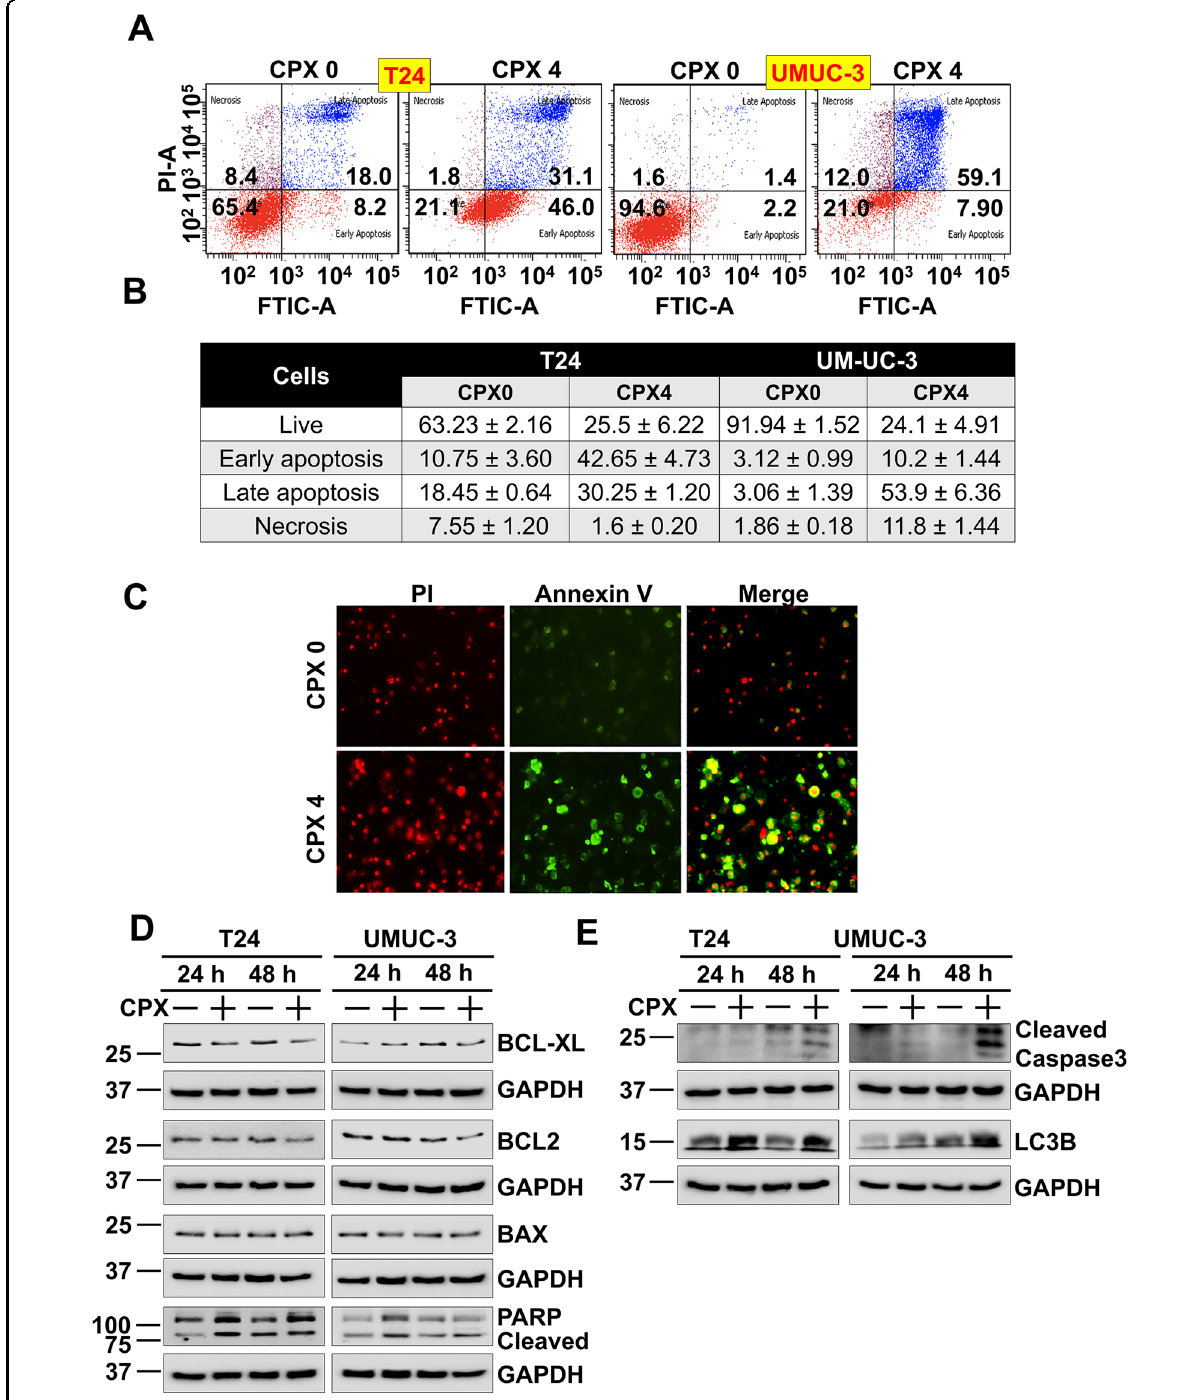
Fig. 3 CPX induces apoptosis in bladder cancer cell lines. A T24 and UM-UC-3 cells were treated with CPX stained with Annexin V (FITC) and PI, and analyzed by fl ow cytometry. CPX treatment induced signi fi cant early and late apoptosis in T24 and UM-UC-3 cells. B The fl ow cytometric quanti fi cation of early and late apoptotic cells after CPX treatment over a period of 72h in T24 and UM-UC-3 cells in Annexin-PI assay. C CPX induces apoptosis in T24 cells. T24 cells treated with CPX (4µM) for 48h were stained with Annexin V-FITC/PI solution and studied using immuno fl uorescence. CPX induced apoptosis in T24 cells. D Lysates from T24 and UM-UC-3 cells treated with CPX were studied by western blot for evaluating the effect on proteins involved in apoptosis. CPX treatment reduced the levels of antiapoptotic marker proteins Bcl2 and Bcl-XL. CPX treatment also increases the PARP cleavage compared to untreated controls. E CPX induces autophagy early which then followed by apoptosis. Lysates from T24 and UM-UC-3 cell treated with CPX (4µM) for 24 – 48h were analyzed by western blot. CPX treatment increased the expression of LC3B at 24h and cleaved caspase-3 expression at 48h. The data suggest that at early time points, CPX induces autophagy, which switches to apoptosis in T24 and UM-UC-3 cells. Of fi cial journal of the Cell Death Differentiation